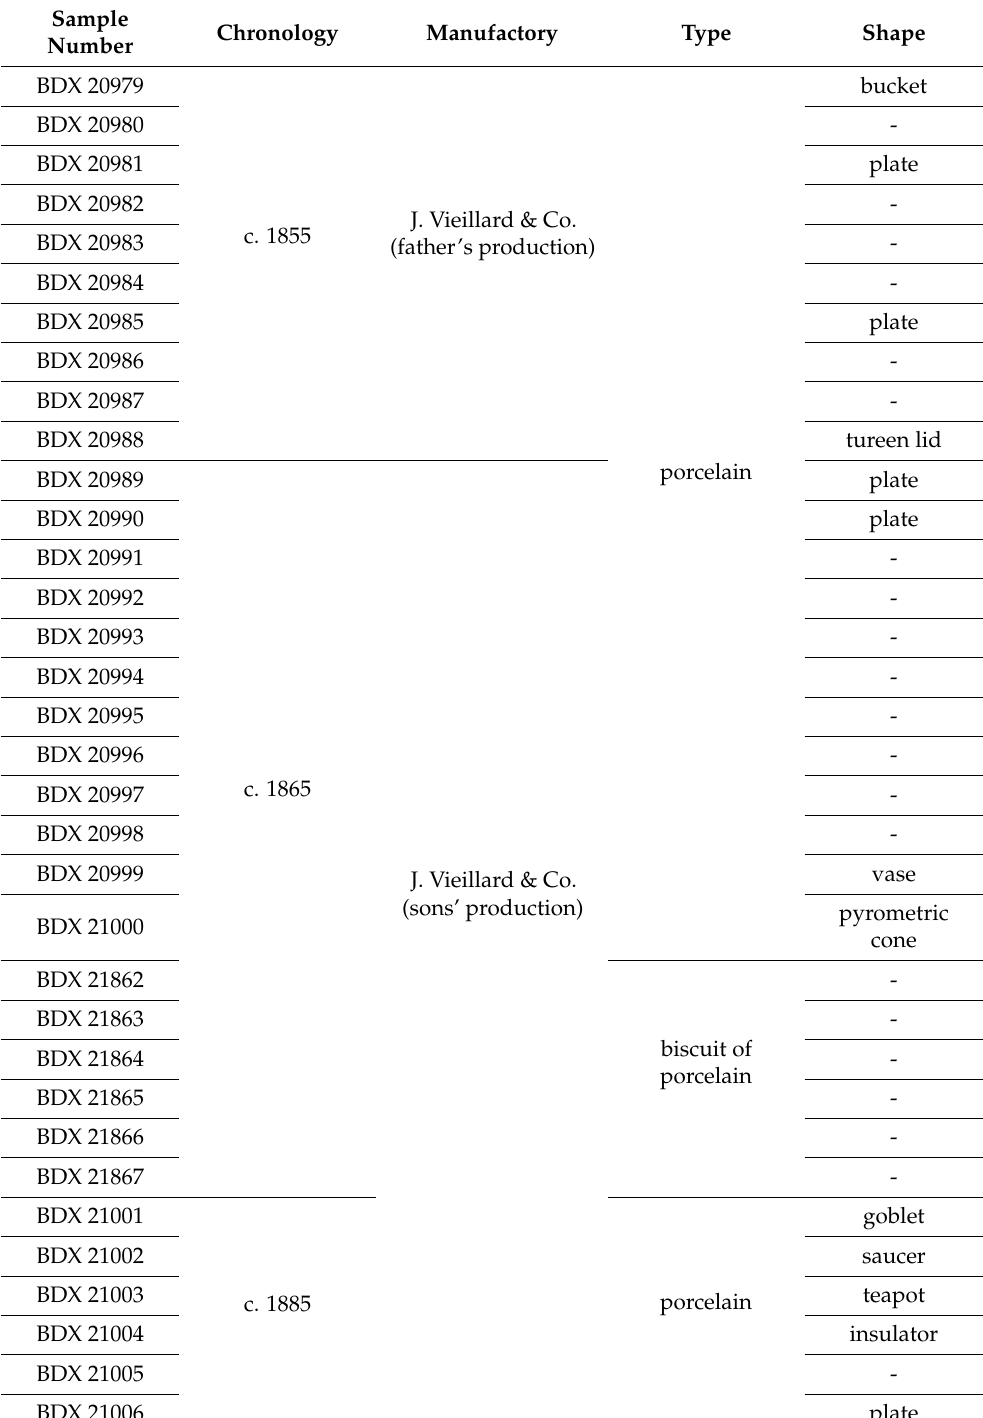
Table 1. Detailed description of the investigated porcelains from the wasted dumps of the Vieillard & Co manufactory (Bordeaux,